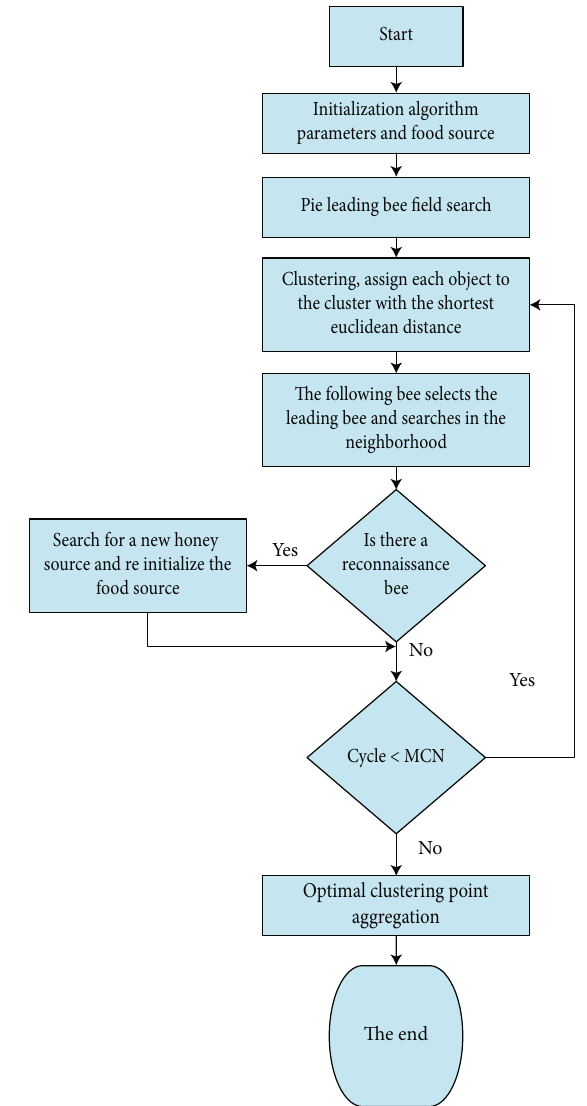
Figure 2: K-means clustering algorithm fl ow based on improved bee colony algorithm.